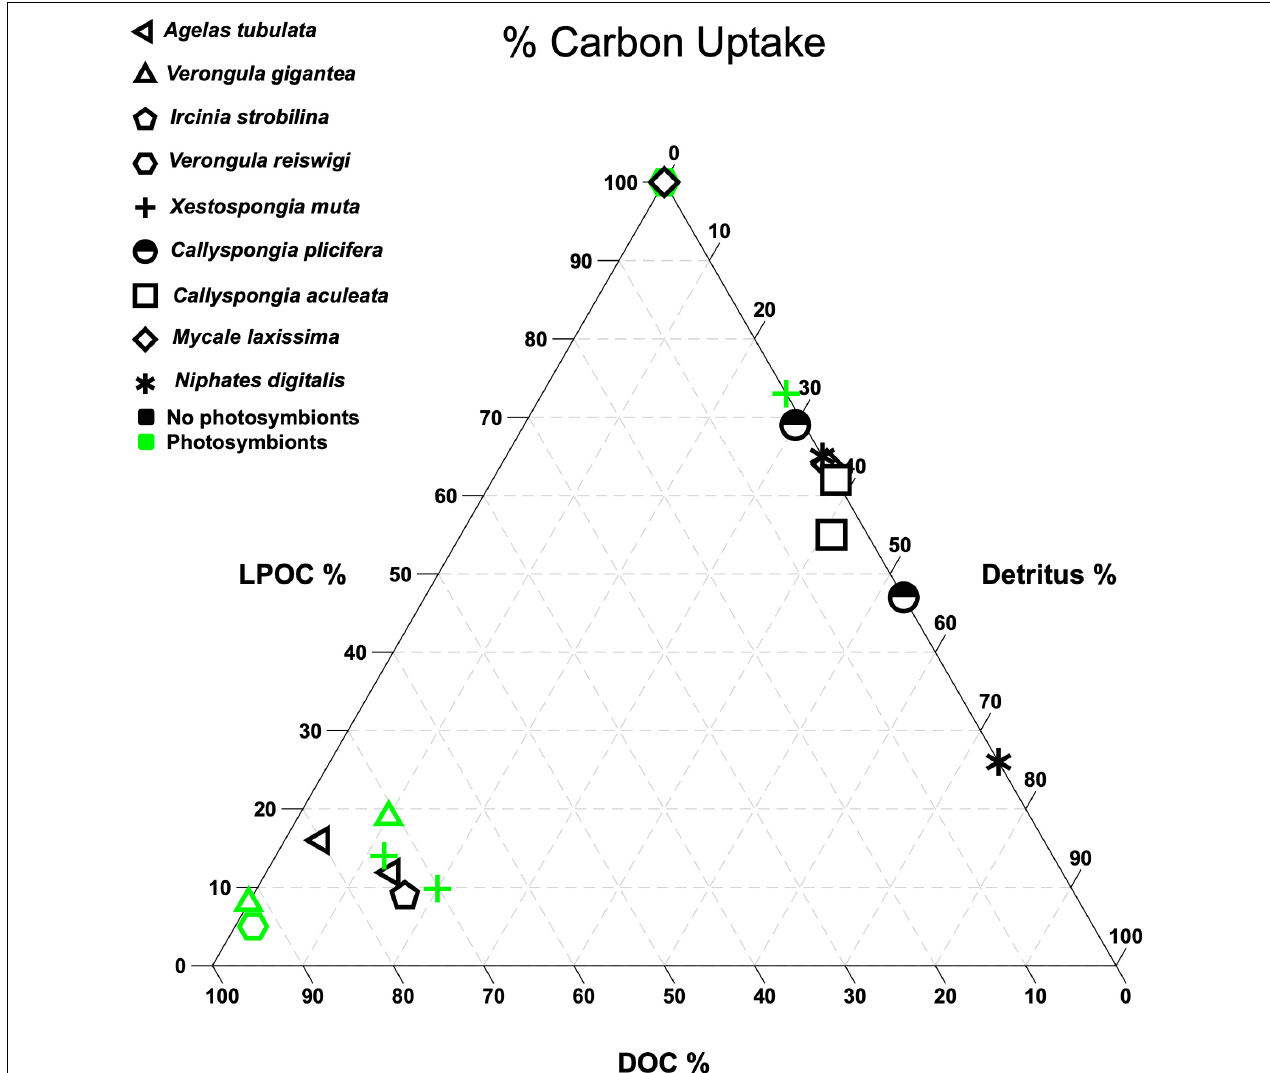
FIGURE 1 | Ternary plot showing the % total carbon uptake (the percent contribution of each food type to the total organic carbon retained by each species). Food types are: dead organic carbon (detritus), living particulate organic carbon (LPOC), and dissolved organic carbon (DOC) (McMurray et al., 2016, 2018). Green symbols denote species or congeners that host communities of photosynthetic symbionts (Erwin and Thacker, 2007; Freeman et al., 2020). Multiple symbols for a species represent variation due to sample collection from different locations or